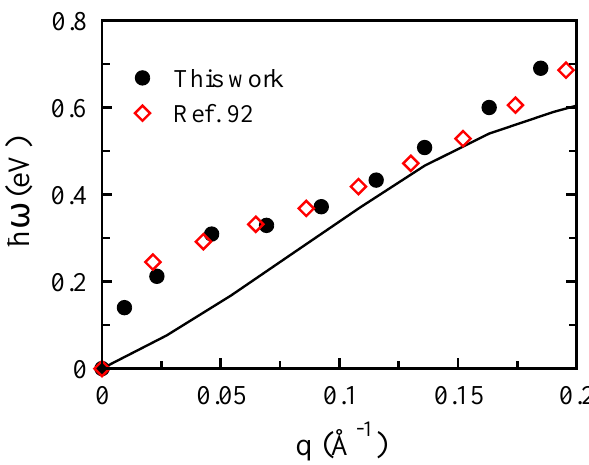
Figure 16. Our calculated plasmon dispersion (dots) of monolayer phosphorene with E F = 0.07 eV along the armchair direction, in comparison with results obtained by Ghosh et al. for monolayer phosphorene and with the same concentration along the armchair direction (open symbols) [92].